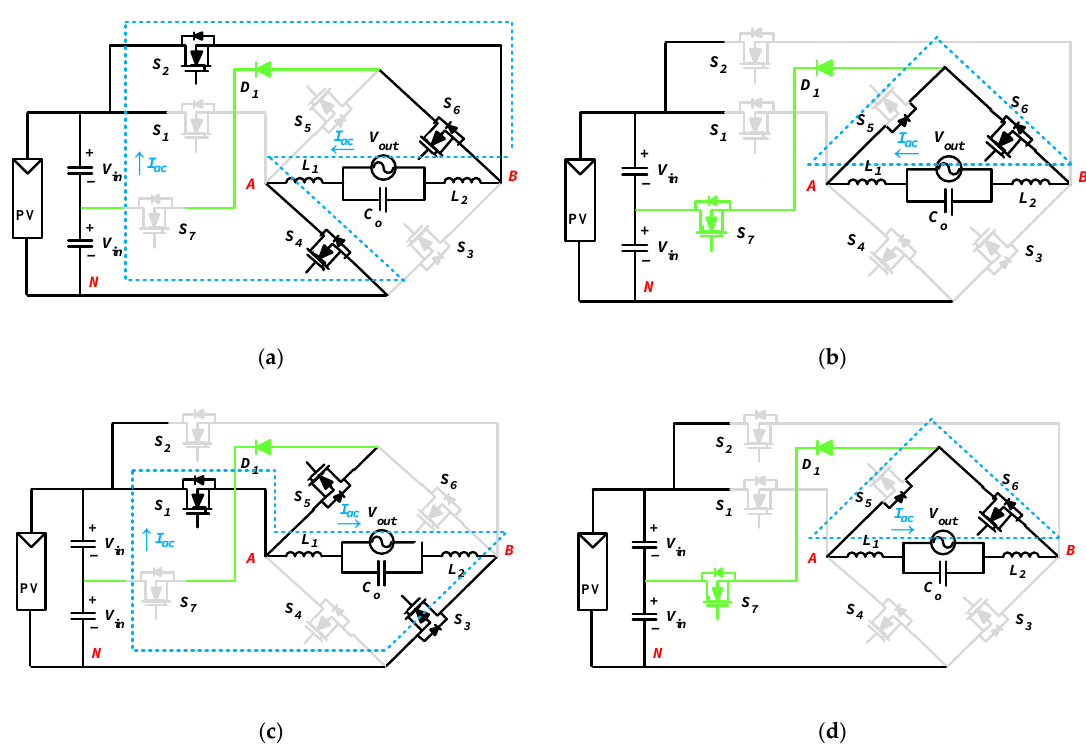
Figure 5. Currents paths and operation modes of the proposed topology. ( a ) Mode 1, ( b ) Mode 2, ( c ) Mode 3, and ( d ) Mode 4.